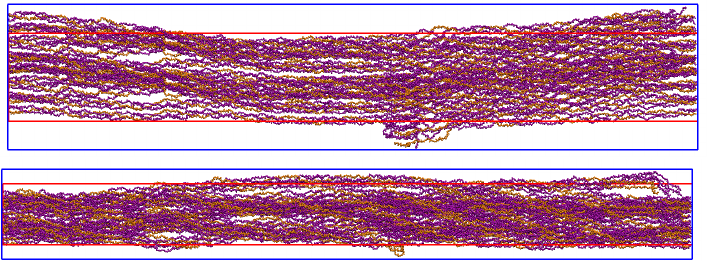
Figure 6. Bone Fiber view (VMD) of yz-plane ( top ) and xz-plane ( bottom ). The simulation box (blue) defines the external boundary of the EFV. The IFV box (red) defines the external boundary of the IFV and the internal boundary of the EFV. Only CLG backbone molecules are shown.